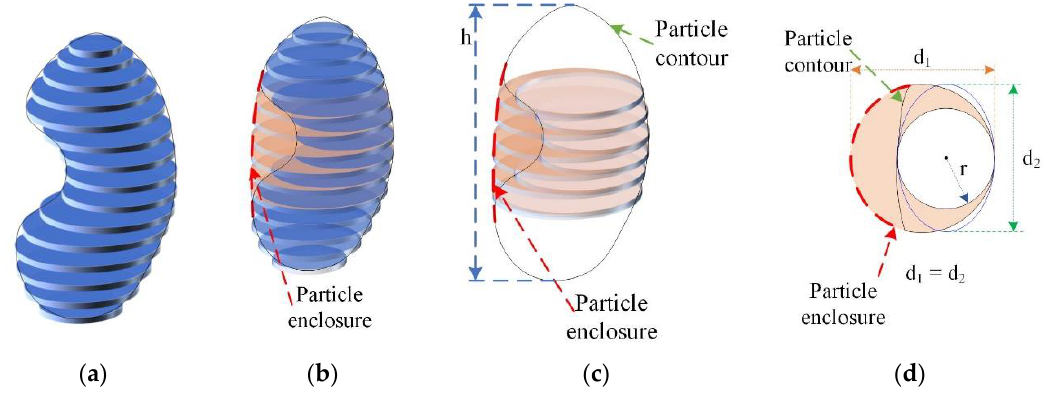
Figure 13. Three-dimensional (3D) model of irregular pellet: ( a ) the pellet’s volume consists of the sum of layer circles; ( b ) shape of the regular pellet is limited by pellet envelope line; ( c ) discrepancy between irregular volume and volume limited by envelope line; ( d ) cross-section of pellet limited by its envelope line.